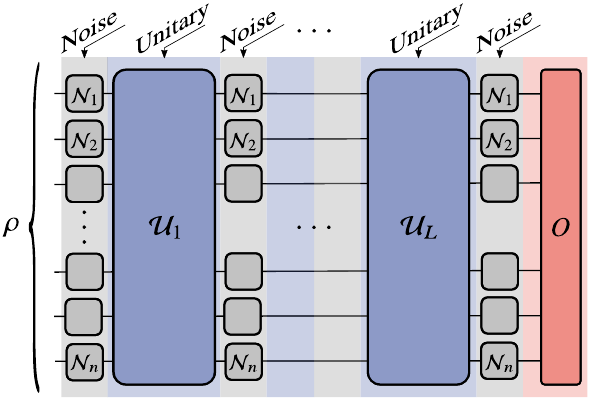
Fig. 2 Setting for our analysis. An n -qubit input state ρ is sent through a variational ansatz U ( θ ) composed of L unitary layers U l ( θ l ) sequentially acting according to Eq. (1). Here, U l denotes the quantum channel that implements the unitary U l ( θ l ). The parameters in the ansatz θ ¼ f θ l g L l trained to minimize a cost function that is expressed as the expectation value of an operator O as in Eq. (2). We consider a noise model where local Pauli noise channels N j act on each qubit j before and after each